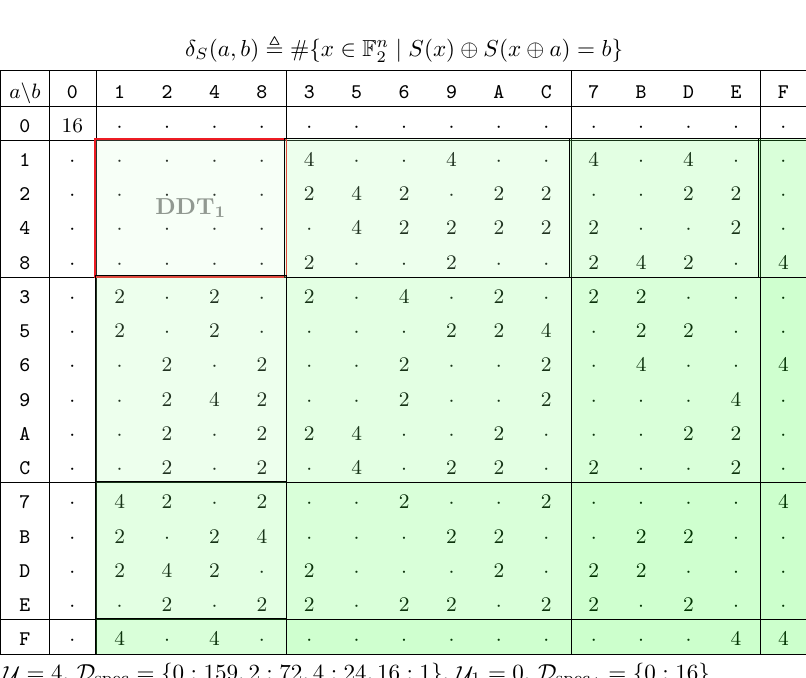
Figure 2: The DDT/DDT 1 of the Serpent S-boxes S 0